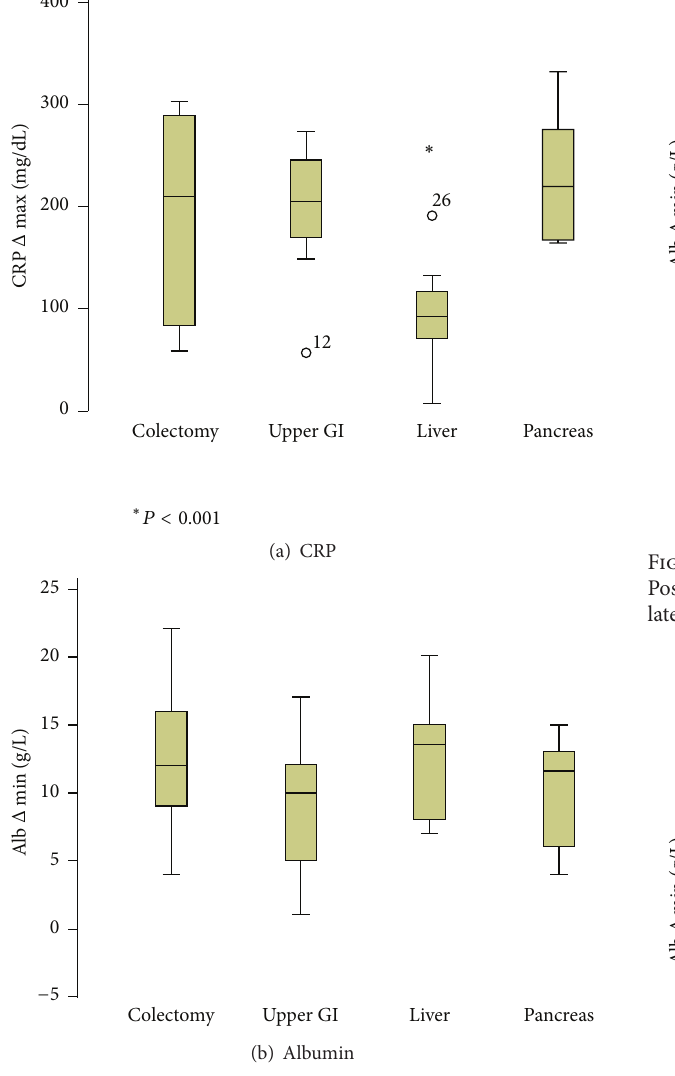
Figure 3: CRP levels and Albumin drop after different major surgery procedures. Maximal C-reactive protein levels (CRP Δ max) for major colon, upper gastrointestinal, liver, and pancreatic resections (a) showing significant lower values for liver resections. Postoperative albumin decrease (Alb Δ min) was equally high for the four different types of surgery (b).